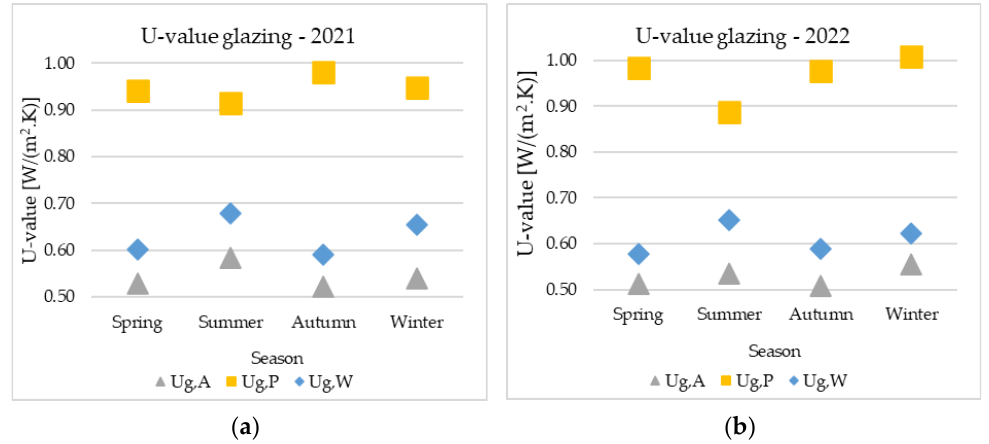
Figure 9. Average u-values for each year: ( a ) U-value in 2021; ( b ) U-value in 2022.